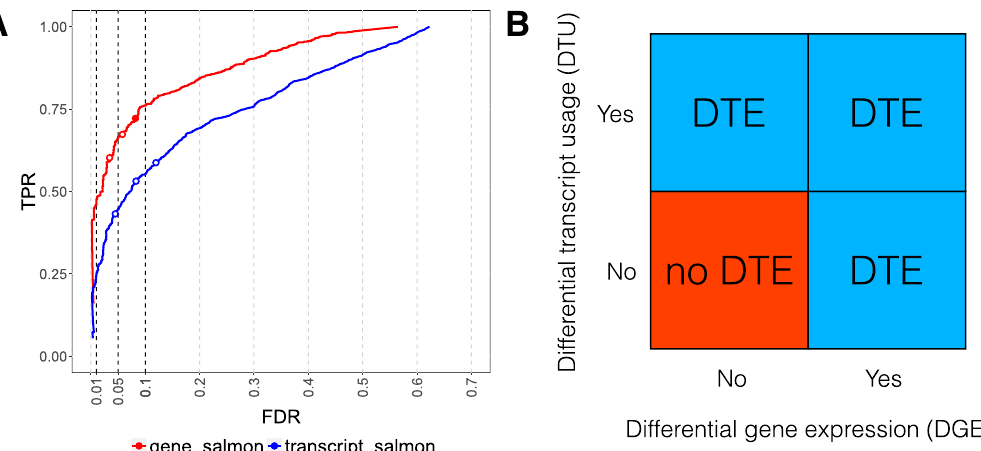
Figure 2 (sim2). A : DTE detection performance on transcript- and gene-level, using edgeR applied to transcript-level estimated counts from Salmon . The statistical analysis was performed on transcript level and aggregated for each gene using the perGeneQValue function from the DEXSeq R package; aggregated results show higher detection power. The curves trace out the observed FDR and TPR for each significance cutoff value. The three circles mark the performance at adjusted p-value cutoffs of 0.01, 0.05 and 0.1. B : Schematic illustration of different ways in which differential transcript expression (DTE) can arise, in terms of absence or presence of differential gene expression (DGE) and differential transcript usage